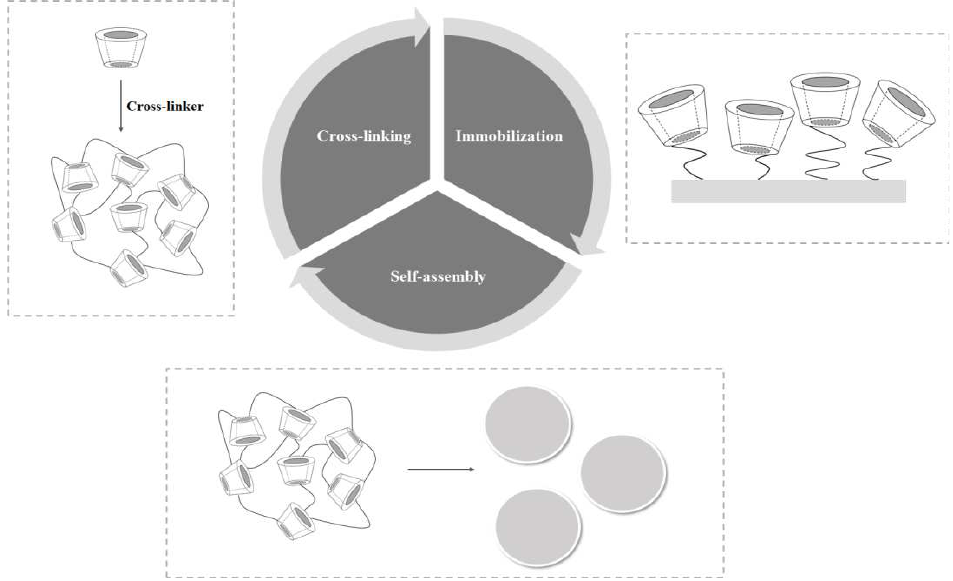
Figure 2. Synthesis scheme for CD-based materials.